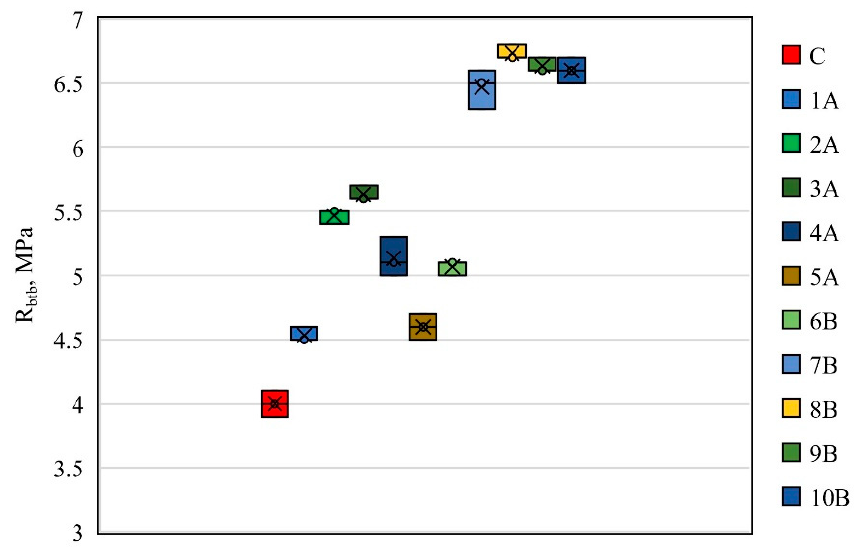
Figure 8. Bending tensile strength of fine-grained geopolymer concrete.